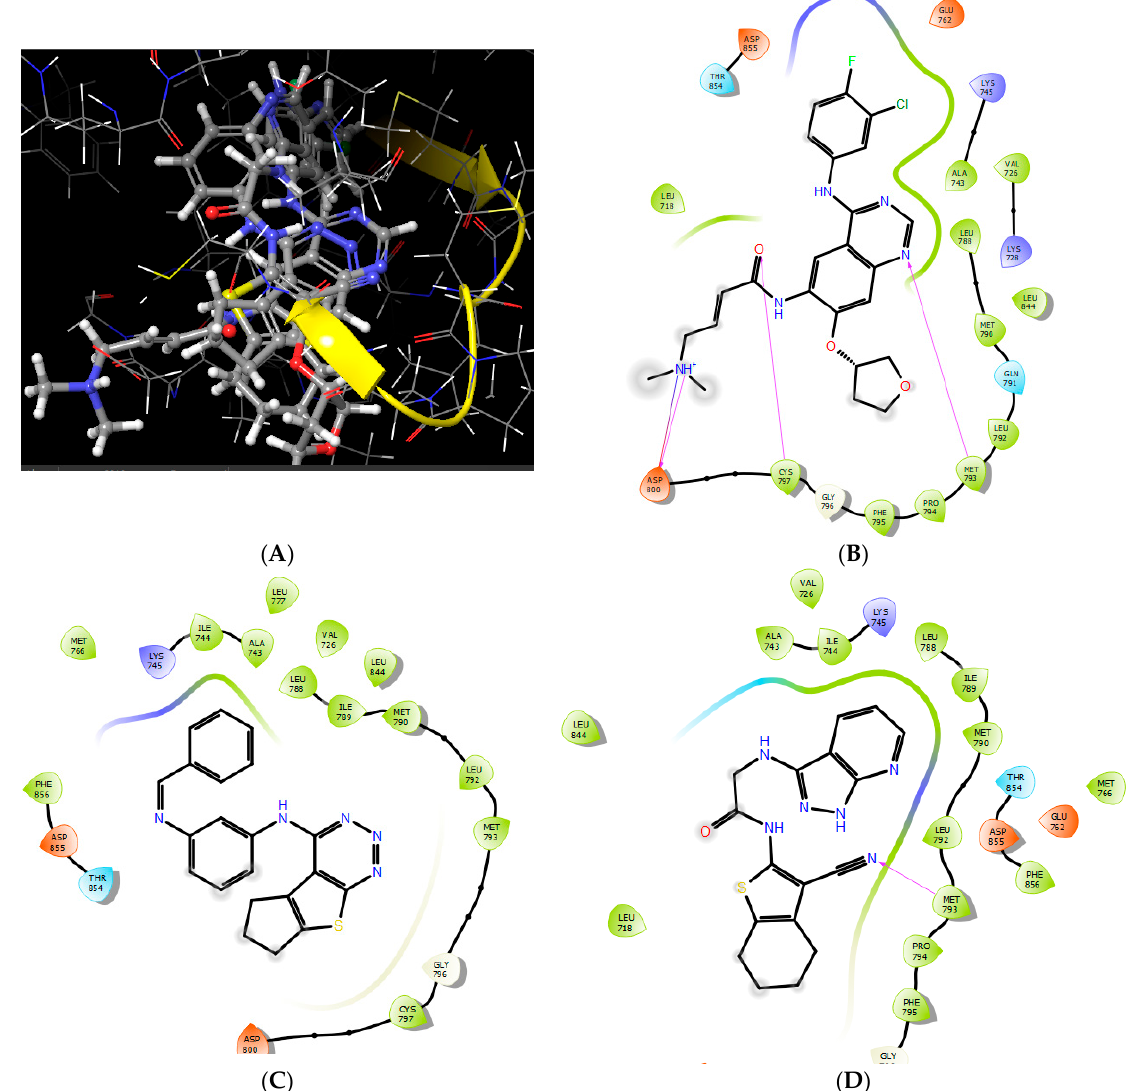
Figure 6. ( A ) Three-dimensional binding modes and overlay of afatinib ( 5 ) and compounds ( 14a ) and ( 21a ) in the catalytic domain of T790M EGFR (PDB 4G5P). ( B ) 2D representation of afatinib ( 5 ) in the catalytic domain of T790M EGFR. ( C ) 2D representation of compound ( 14a ) in the catalytic domain of T790M EGFR. ( D ) 2D representation of compound ( 21a ) in the catalytic domain of T790M EGFR.